Question: What caption would you write for this figure?
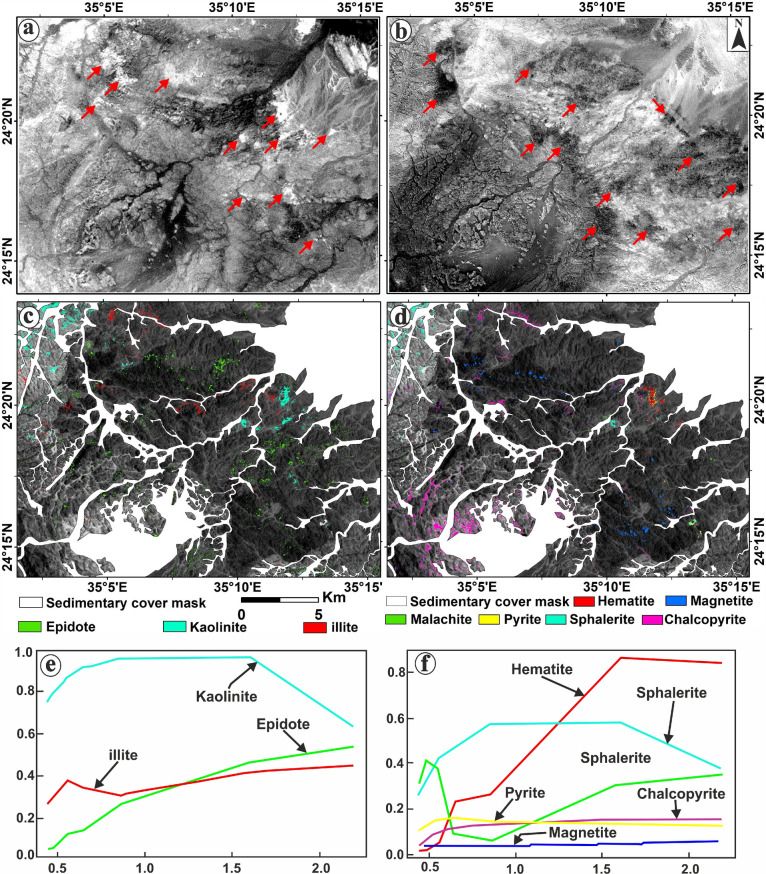
Answer: ( a ) PC4 greyscale ASTER Image, ( b ) PC3 greyscale ASTER Image, ( c ) CEM classification endmember for alteration minerals (illite, kaolinite, and epidote) using VNIR-SWIR Landsat-8 data and the USGS resampled spectral library, ( d ) CEM classification endmember of valuable minerals associated with alteration zones using VNIR-SWIR Landsat-8 data and the ASTER resampled spectral library, ( e ), ( f ) Endmember collection spectra used in CEM spectral classification method using USGS spectral library and ASTER spectral library for VNIR-SWIR bands. Solid colored lines symbolize the Landsat-8 bands’ wavelength. This figure is generated by Envi 5.3 software ( https://www.nv5geospatialsoftware.com/ ) and exported by ArcGIS Desktop 10.8 software ( https://www.esri.com/en-us/arcgis/products/arcgis-online ).